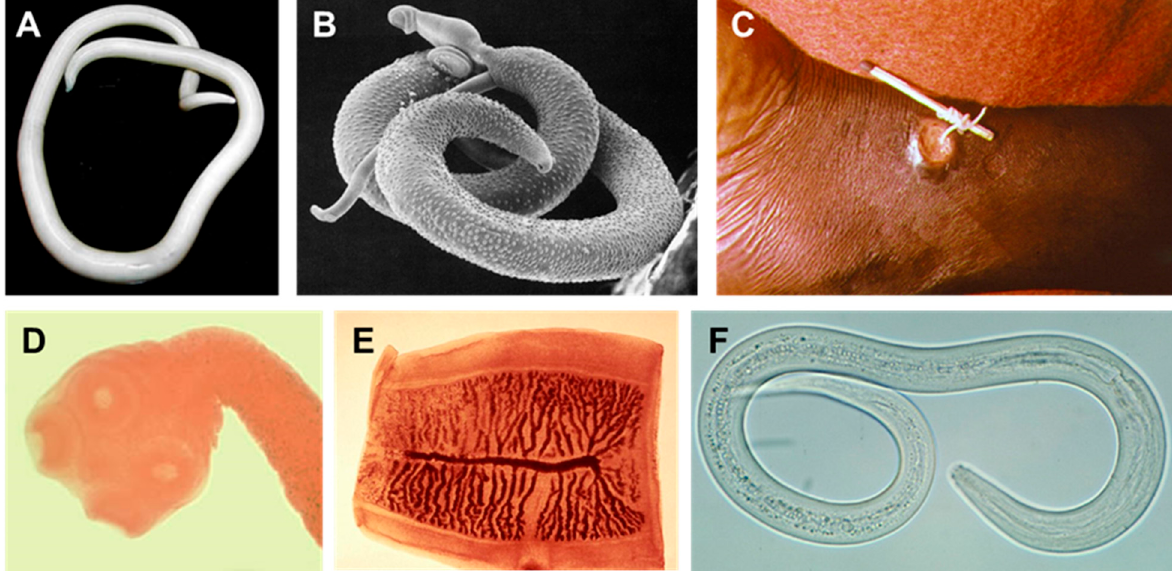
Figure 1. Examples of human helminths. ( A ) Female Ascaris lumbricoides (large human roundworm). ( B ) Schistosoma mansoni male and female. The smaller female resides in the tegumental fold of the male. ( C ) Dracunculus medinensis (Guinea worm) emerging from a human ankle. ( D , E ) Taenia saginata (beef tapeworm) scolex (head) and proglottid segment. ( F ) Ancylostoma duodenale (one of the two species of hookworm). All images reside in the public domain.